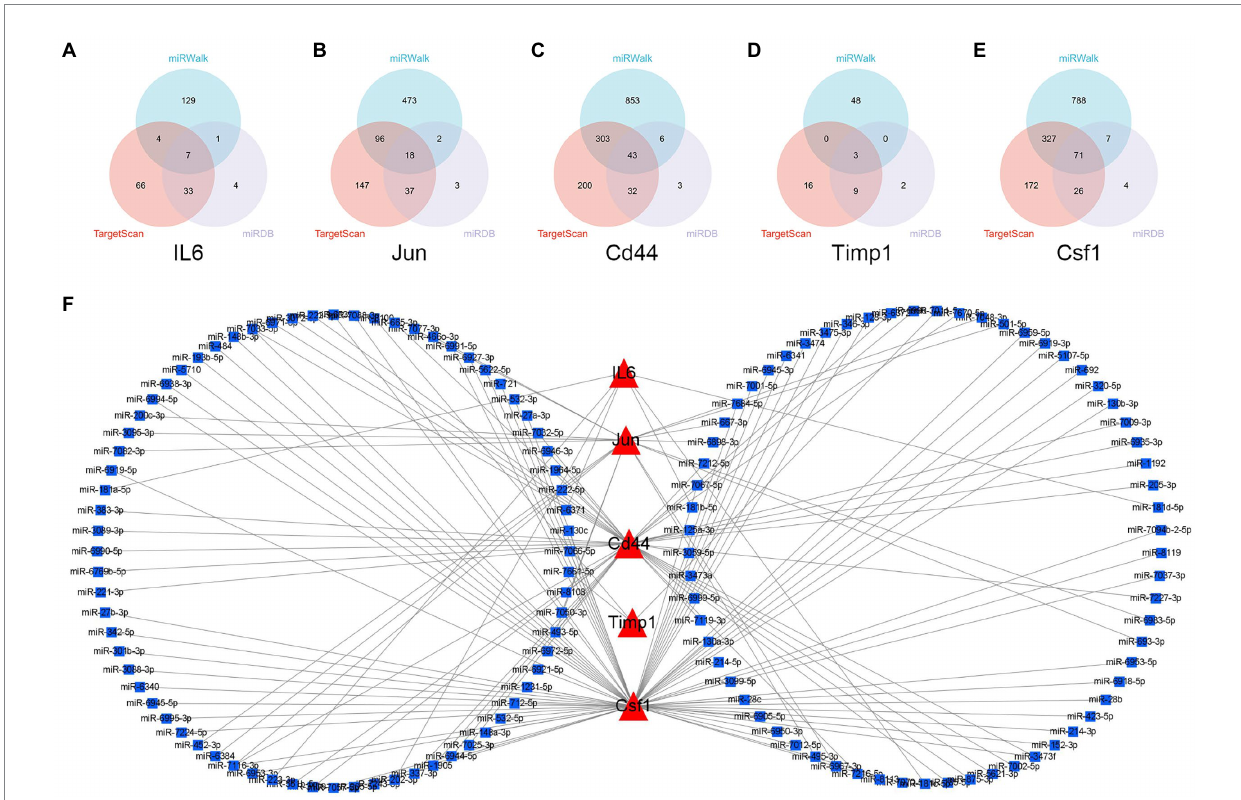
FIGURE 5 Construction of miRNA-mRNA network. (A–E) Overlap analysis for the miRNAs binding to the IL6, Jun, Cd44, Timp1, and Csf1 from the TargetScan, miRWalk, and miRDB database. (F) The miRNAs-hub genes